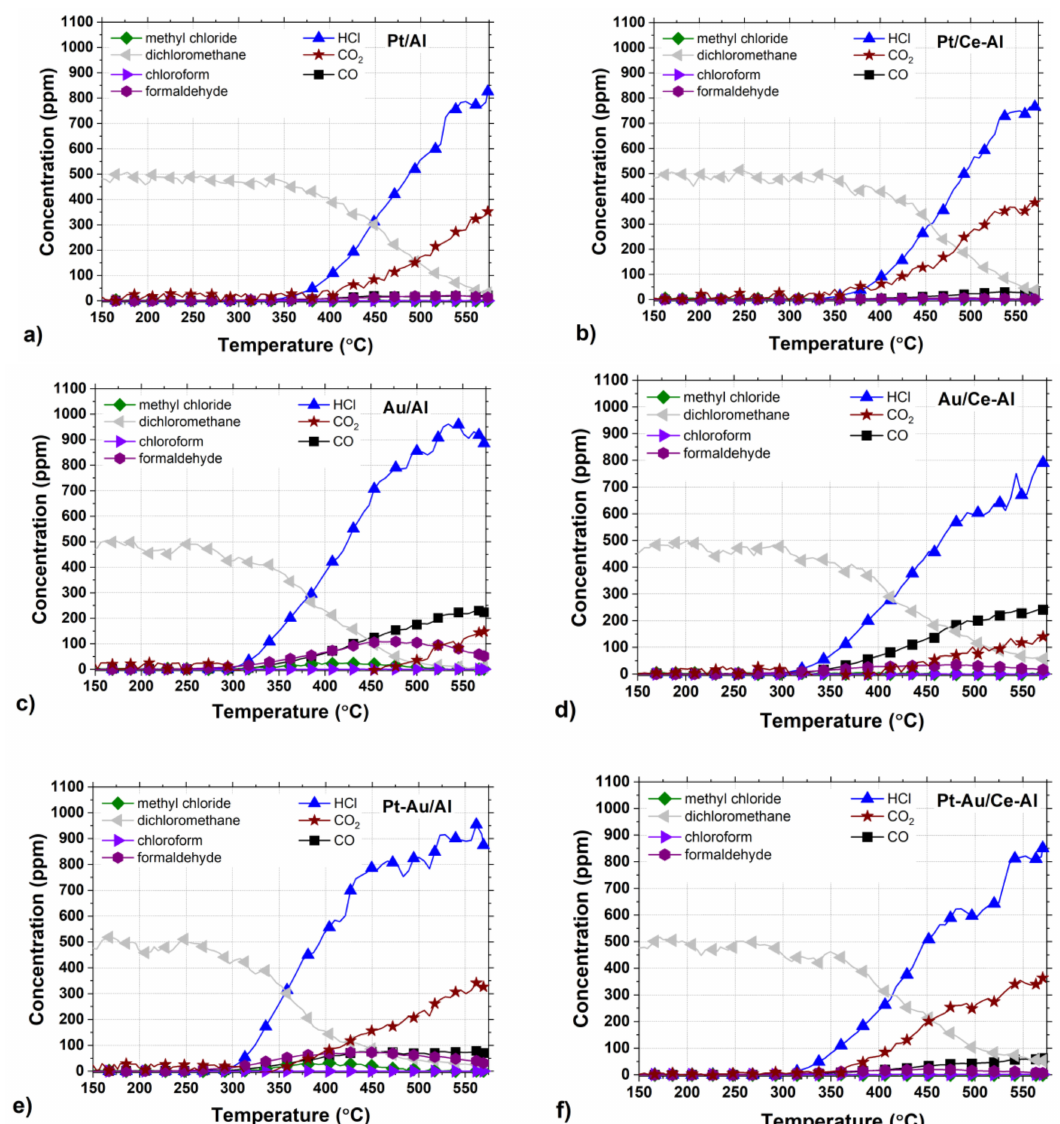
Figure 7. The product concentrations of the Pt, Au, and Pt-Au catalysts supported on ( a – c ) Al 2 O 3 and on ( d – f ) CeO 2 -Al 2 O 3 in DCM oxidation (same conditions as in Figure